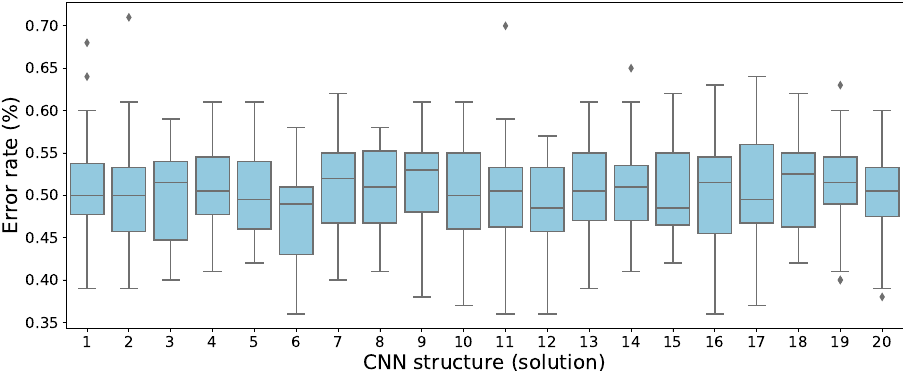
Figure 5. Boxplot of the error rate distribution of the best 20 solutions generated by the MBO algorithm.